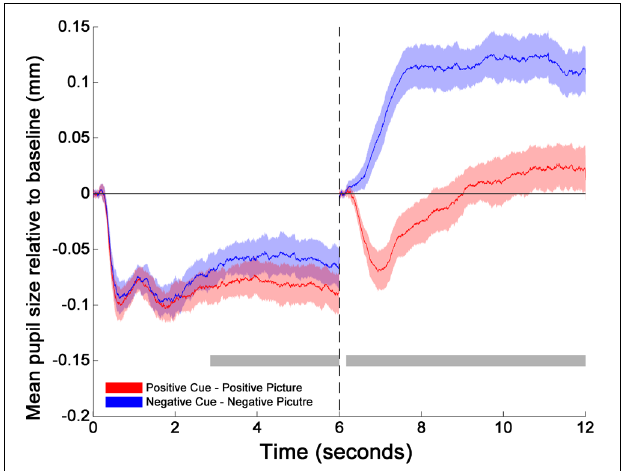
FIGURE 1 | Changes in pupil size relative to baselines across time for cues and pictures. The transition of the two phases is marked by the dotted line at 6s. The two horizontal gray bars mark the time windows within which the differences between positive (red solid line) and negative (blue solid line) emotion trials are statistically significant as indicated by the cluster thresholding method. The colored shades surrounding each mean pupil responses (solid lines) indicate the 95% confidence intervals of the difference between Positive and Negative emotion trials. They are constructed based on the critical paired-sample t scores at each time point (Standard Error × t scores at the 2.5 and 97.5th percentiles of the permuted t distribution). 0–165 and 6000–6165ms were the baseline